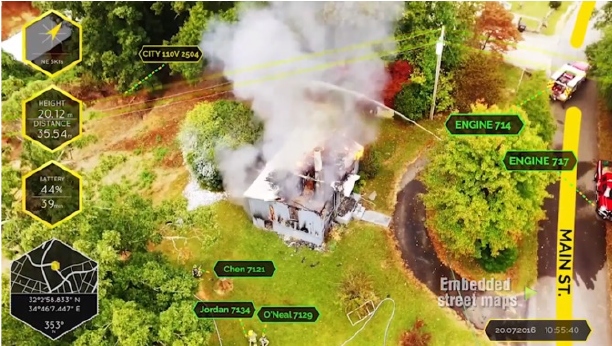
Figure 23: Metaverse for emergency response system